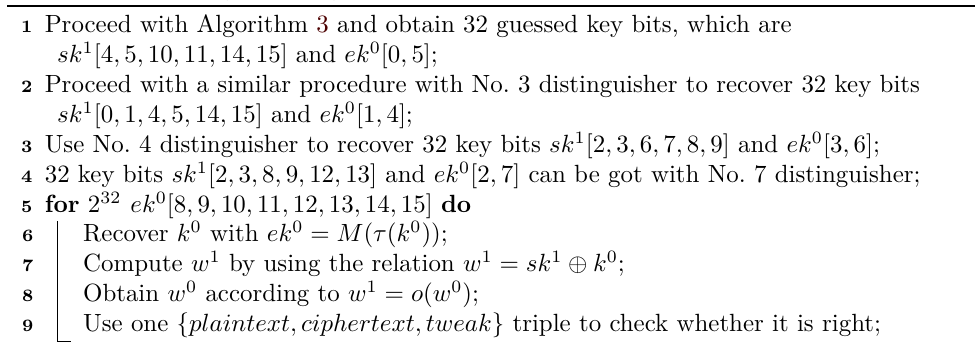
Algorithm 2: Key Recovery Procedure of 10-Round QARMA -64